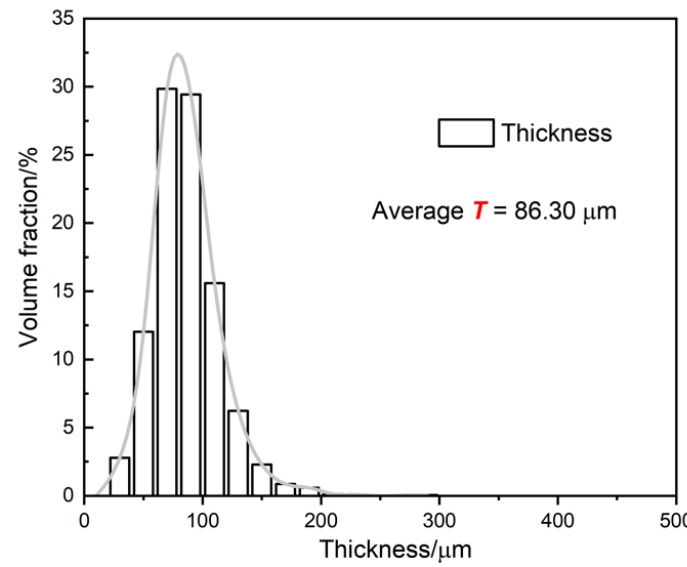
Figure 5. Volume-based distribution histogram for the thickness, T .